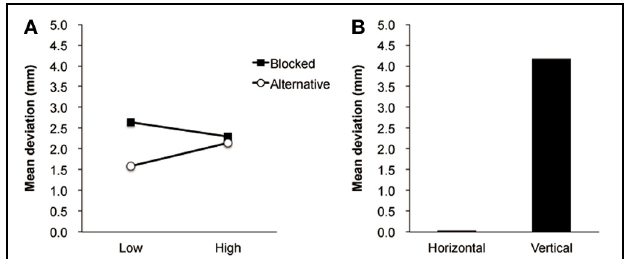
FIGURE 1 | (A) The mean deviations of line bisection for pitch in each presentation order. (B) The mean deviations of line bisection for horizontal and vertical line